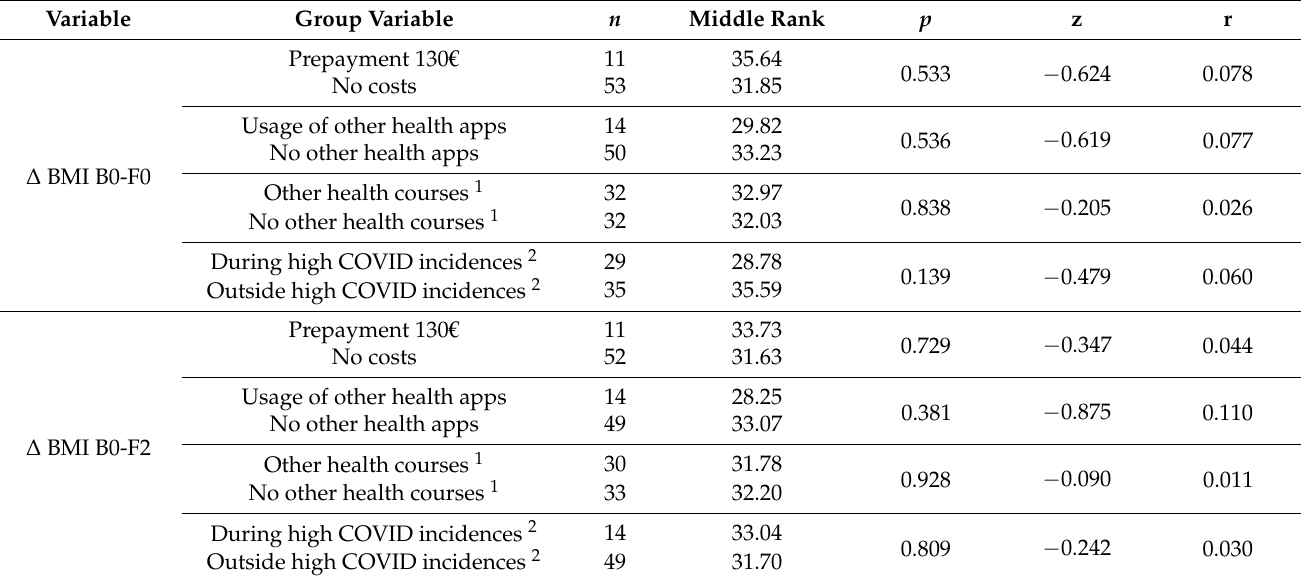
Table A13. Mann-Whiney-U test: Influence of different factors on the effect of the app on the BMI between the different measurement points and